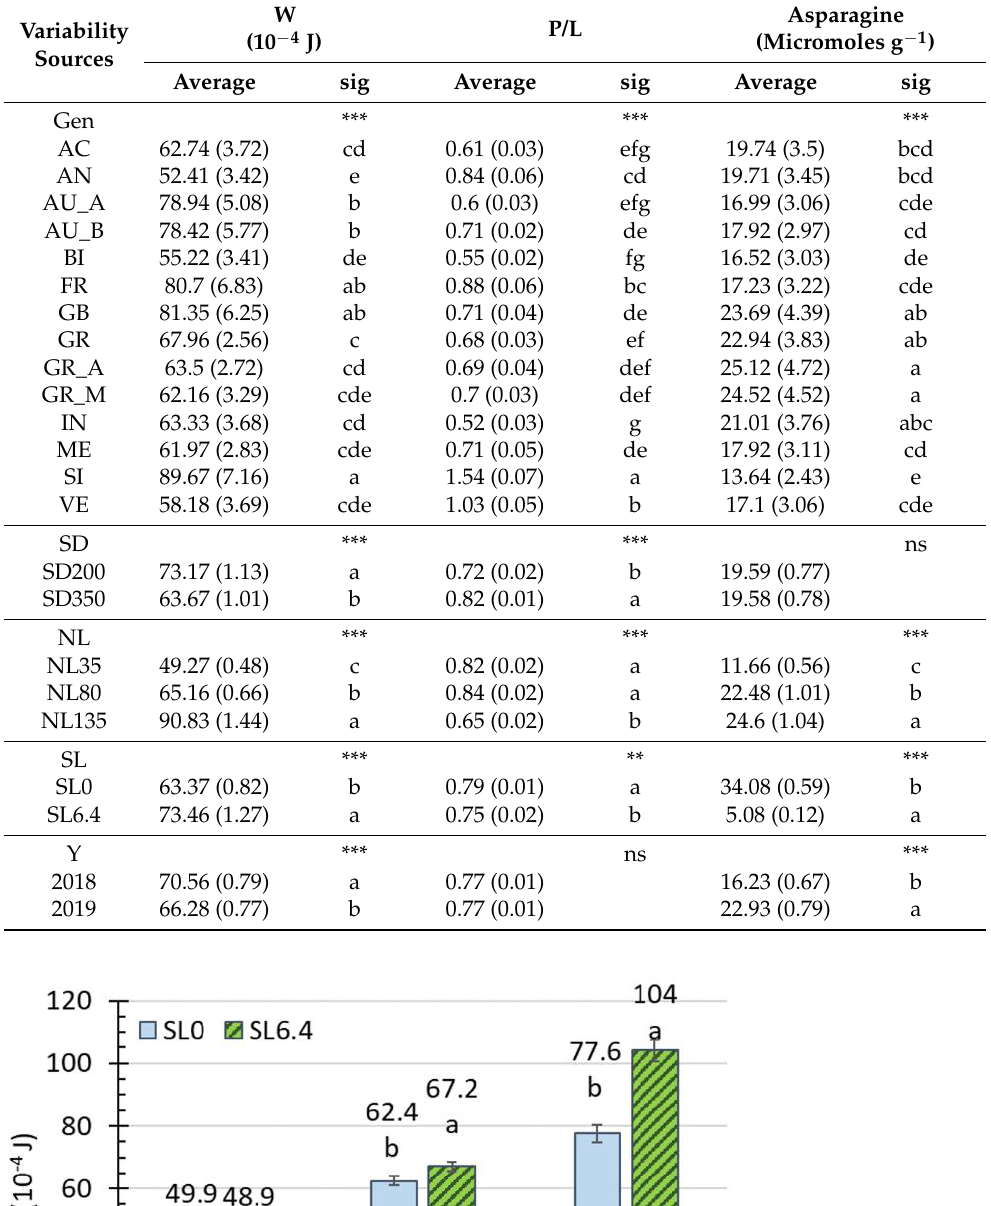
Table 6. Averages (standard error in brackets) of dough strength (W), the ratio between dough tenacity and dough extensibility (P/L), and asparagine concentration in whole flour as a function of genotype (Gen), nitrogen (NL) and sulfur fertilization (SL), seeding density (SD), and first-order interaction. Lowercase letters represent the Tukey HSD post hoc test results. The table columns report the significance levels: ** = 0.01, *** = 0.001, ns = not significant.